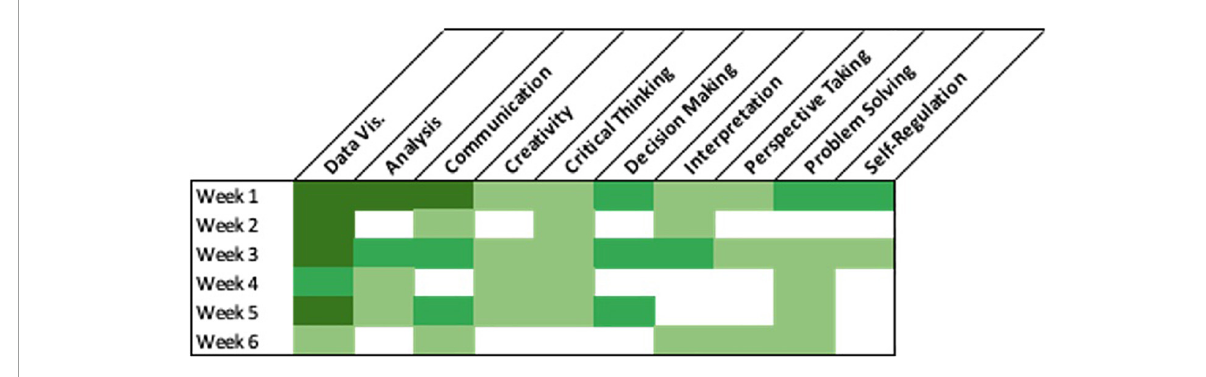
FIGURE3 Heatmap of the key skills and when in the Visual Analytics Certificate course those skills are present.